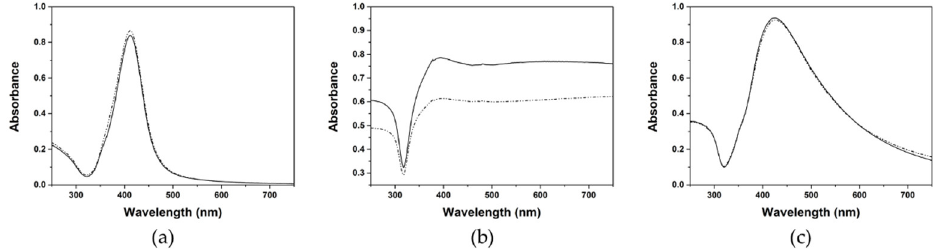
Figure 1. ( a ) TEM images show morphology and particles dispersion. Particles of 15 (PVP-Ag15nm NPs), 50–80 (PVP-Ag50–80nm NPs), and 100 nm (PVP-Ag100nm NPs) are shown. Scale bar of 200 nm. ( b ) Particle size distribution, estimated by measuring an average of 200 particles, and Gaussian fitting are represented by histograms and continuous line, respectively.